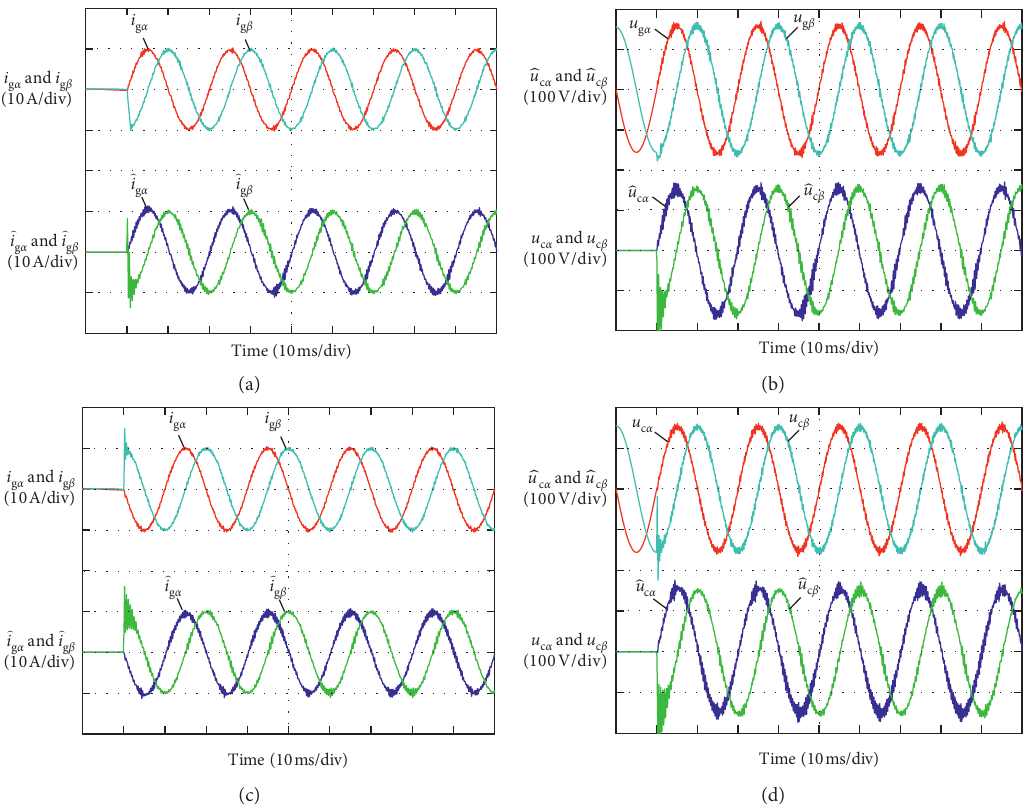
Figure 12: Simulation results of full-dimensional state observers. (a) Waveforms of actual and estimated grid current when PCS is discharging. (b) Waveforms of actual and estimated capacitor voltage when PCS is discharging. (c) Waveforms of actual and estimated grid current when PCS is charging. (d) Waveforms of actual and estimated capacitor voltage when PCS is charging.